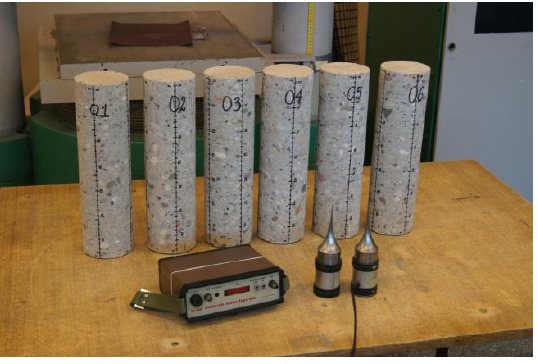
Figure 1. The samples to be tested using ultrasonic device.